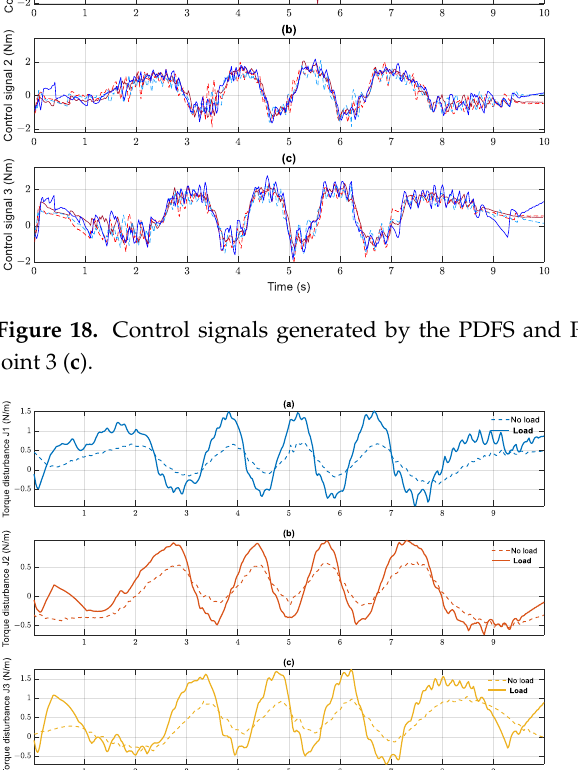
Figure 19. Disturbance torque estimations comparison in case 2: joint 1 ( a ), joint 2 ( b ), joint 3 ( c ). Table 11. RMSE Comparison among the controllers and PDAFS in Parabolic Case 1.